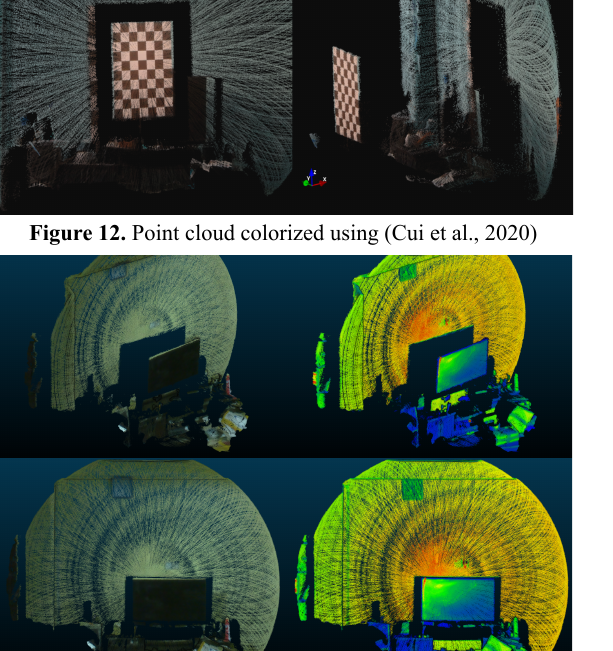
Table 2. Software components and